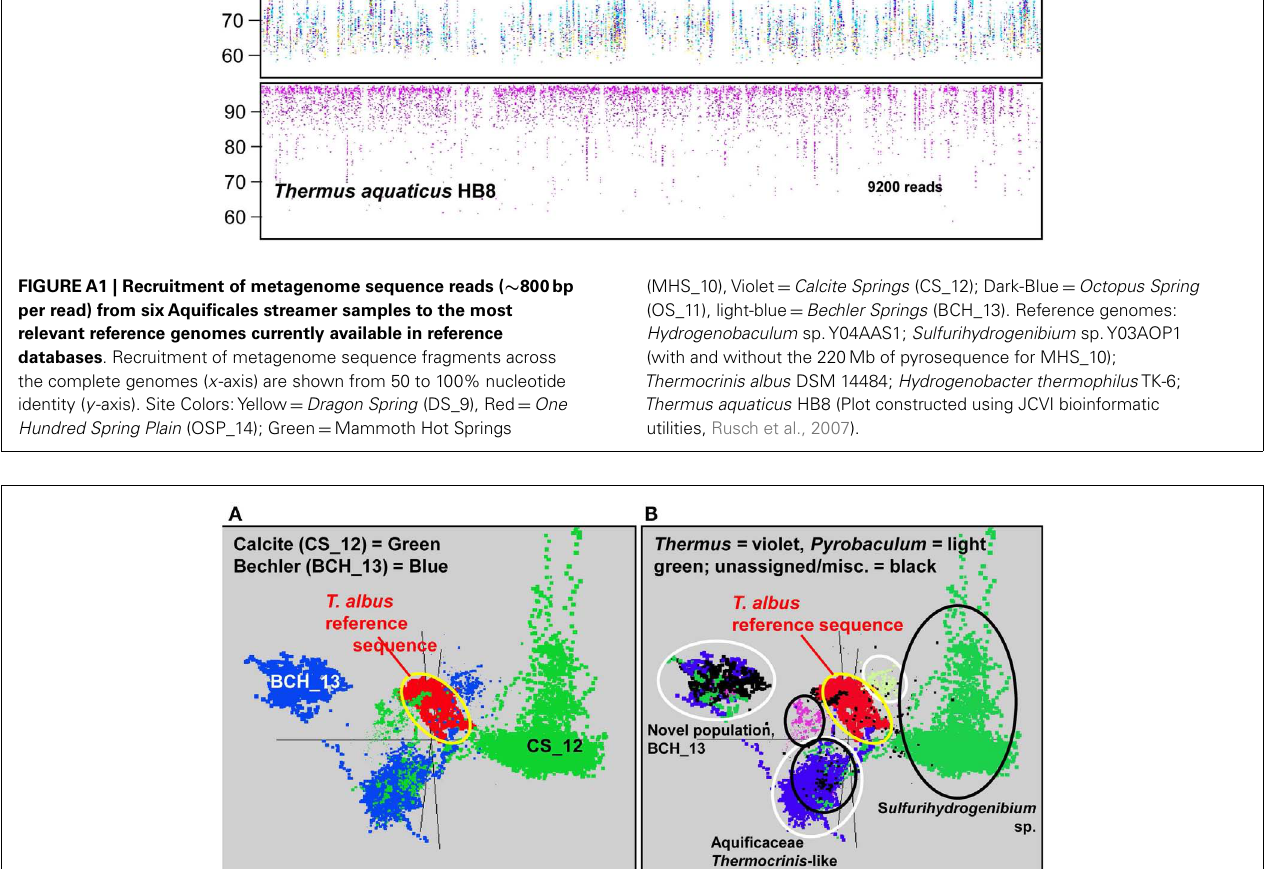
FIGUREA2 | Nucleotide word frequency PCA plots showing detailed analysis ofThermocrinis-like populations in Calcite and Bechler Springs compared toThermocrinis albus reference sequence and other phyla present in these two communities . (A) Sequence data colored by site (CS_12 and BCH_13), with T. albus reference sequence (red) added for comparison., and (B) Sequence data in identical orientation now analyzed